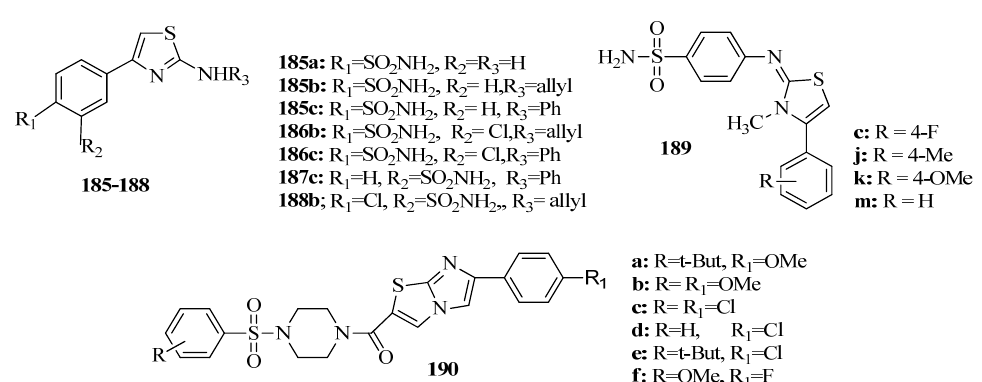
Figure 71. Structures of para-or meta chloro-substituted thiazolylbenzenesulfonamides, 4-[(3- methyl-4-aryl-2,3-dihydro-1,3-thiazol-2-ylidene)amino]benzene-1-sulphonamides and imidazo[2,1-b]thiazole-sulfonyl piperazines ( 190 ).